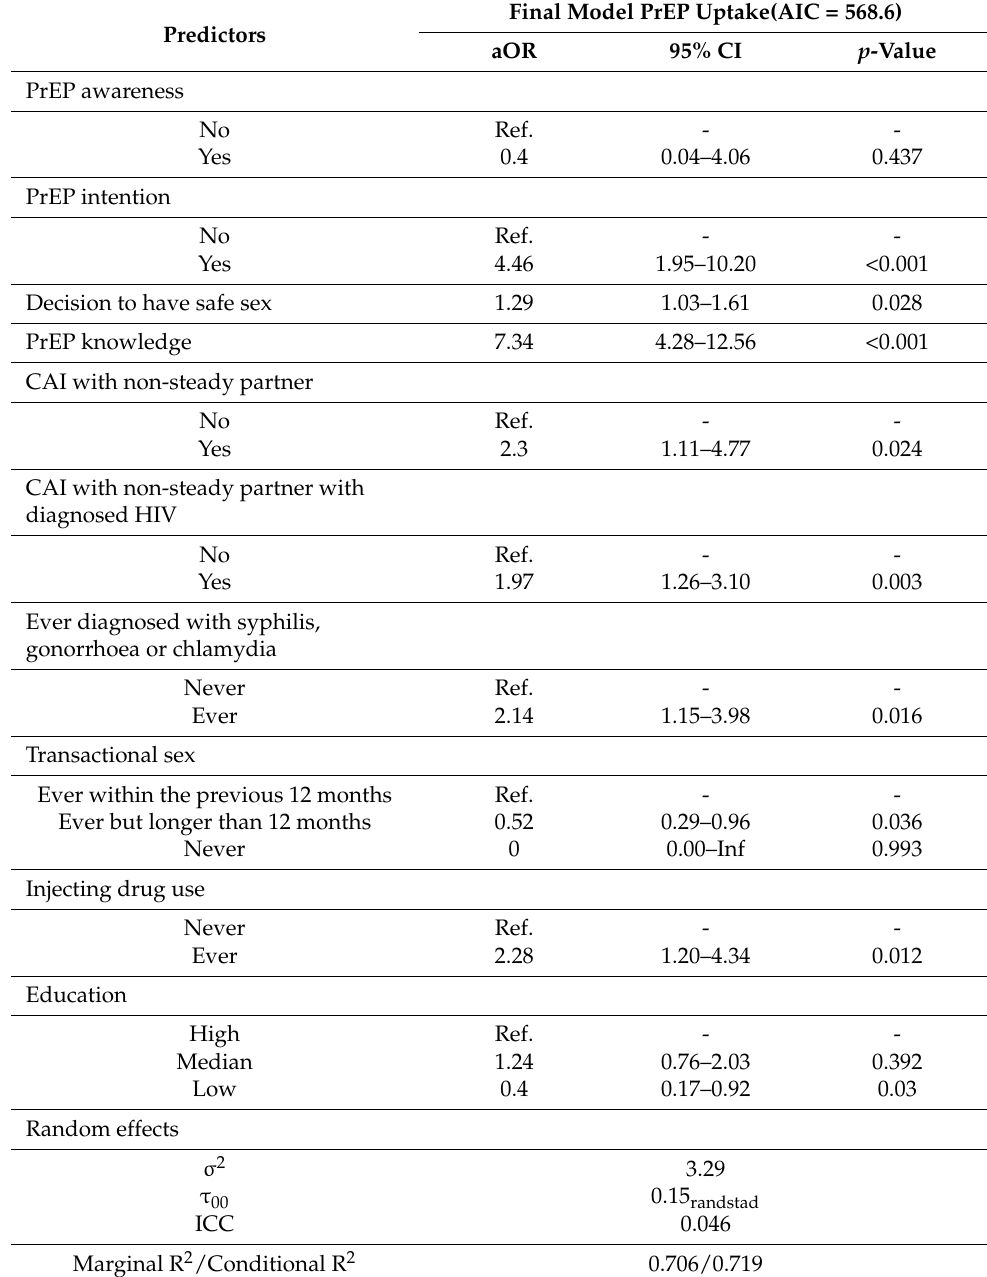
Table 3. Generalised logistic mixed final models: variation between regions and the determinants of PrEP uptake.